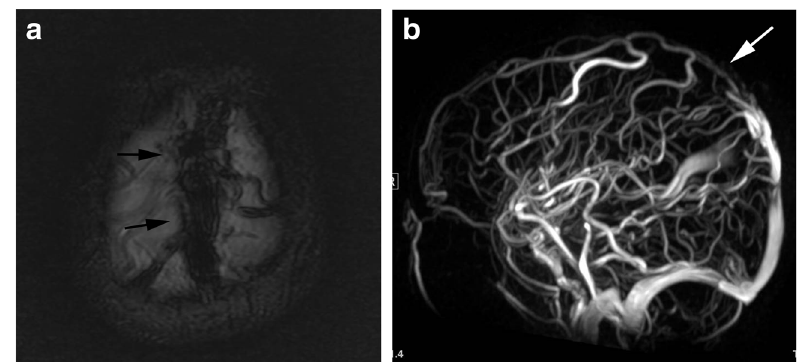
Fig. 5 Trousseau ’ s